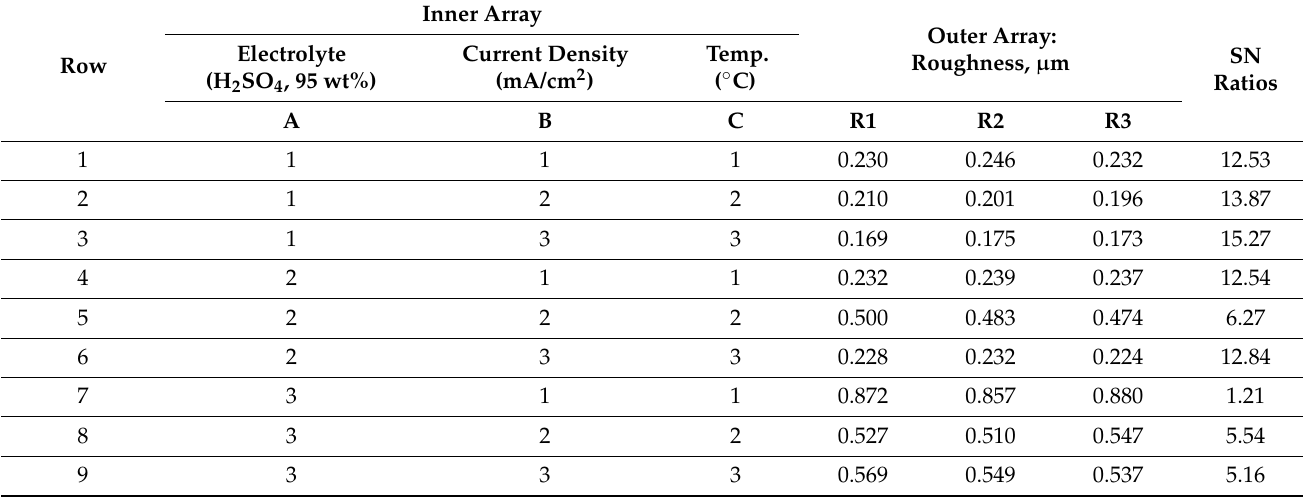
Table 4. UNS N08367 roughness signal-to-noise